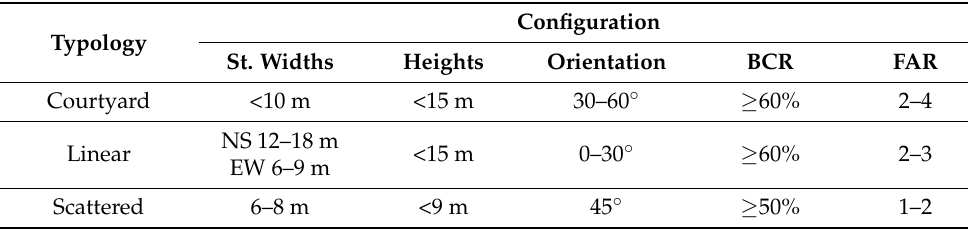
Table 5. Design recommendations for the optimum design thresholds in each typology.